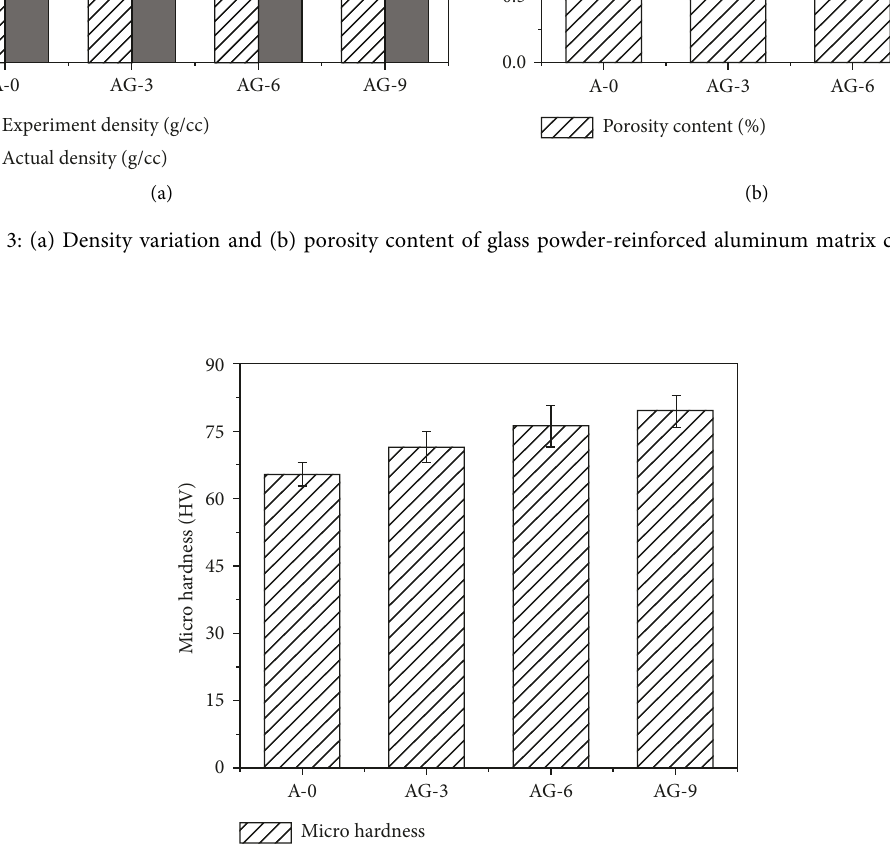
Figure 4: Variation of microhardness of AA7075 alloy and cast